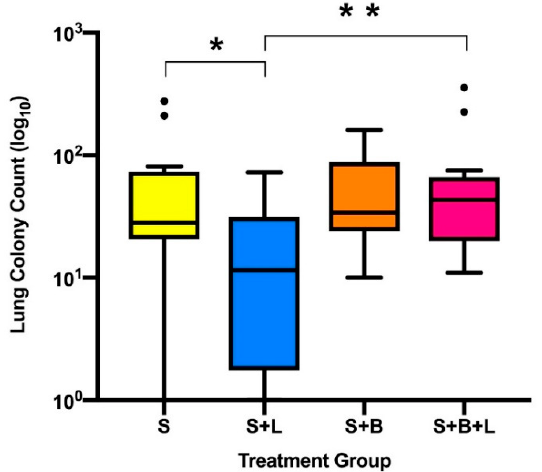
Figure 2. Lung metastatic colony counts by treatment group (median, IQR and range). * indicates difference between group S and S + L ( p = 0.041), ** indicates difference between groups S + L and S +